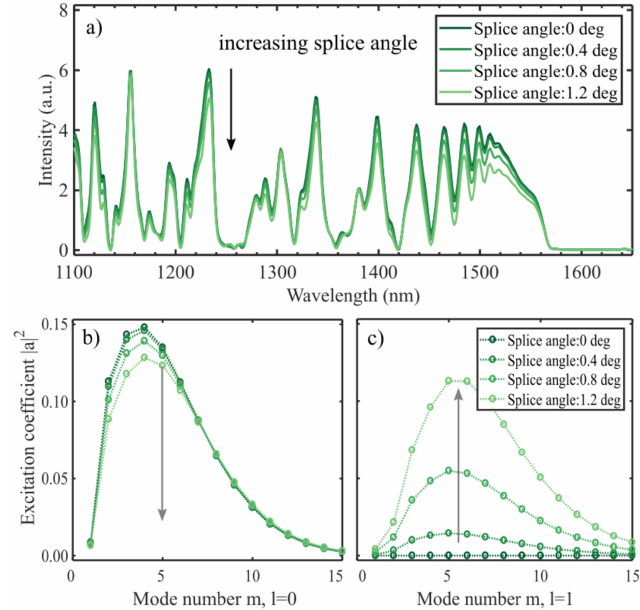
Figure 8. The spectra from a 14.2 mm CL interferometer which is spliced to the input fiber at an angle ( a ). To show the e ff ect, the angles used are larger than what can be expected experimentally. An angled splice causes a lower overall intensity, as well as a small reduction in visibility of the interference. The excitation coe ffi cients ( b , c ) are calculated at the splice between the SMF and the CL fiber (Equation (3)) for l = 0 and l = 1. With a larger o ff set more power is going into the azimuthal modes ( c